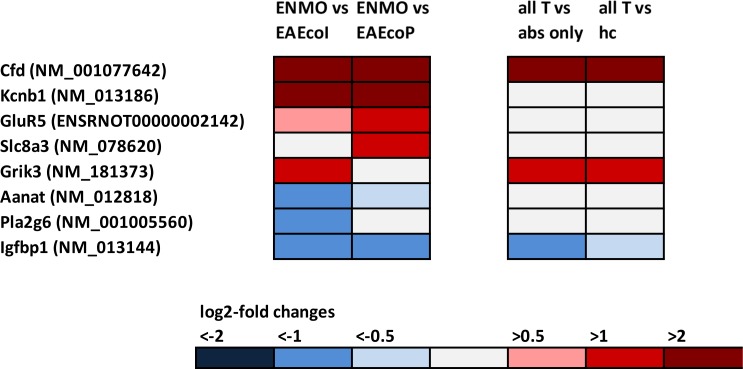
Footprints of genes suggesting astrocyte responses to excitotoxicity and injury in the spinal cord, as revealed by microarray analysis.In the first column of pairwise comparison of log2-fold changes in gene expression, mean values were compared between rats receiving T cells and NMO-IgG (ENMO, n = 5) and their counterparts receiving T cells and subcuvia as control IgG (EAEcoI, n = 5) or T cells and PBS (EAEcoP, n = 5). In the second column of pairwise comparison of log2-fold changes in gene expression, mean values were compared between a group containing all ENMO plus EAEcoI plus EAEcoP animals (n = 15, “all T”) and a group containing animals injected with antibodies only (“abs only” (5 animals with NMO-IgG plus 5 animals with subcuvia as control IgG) or containing healthy control animals only (“hc”, n = 3).